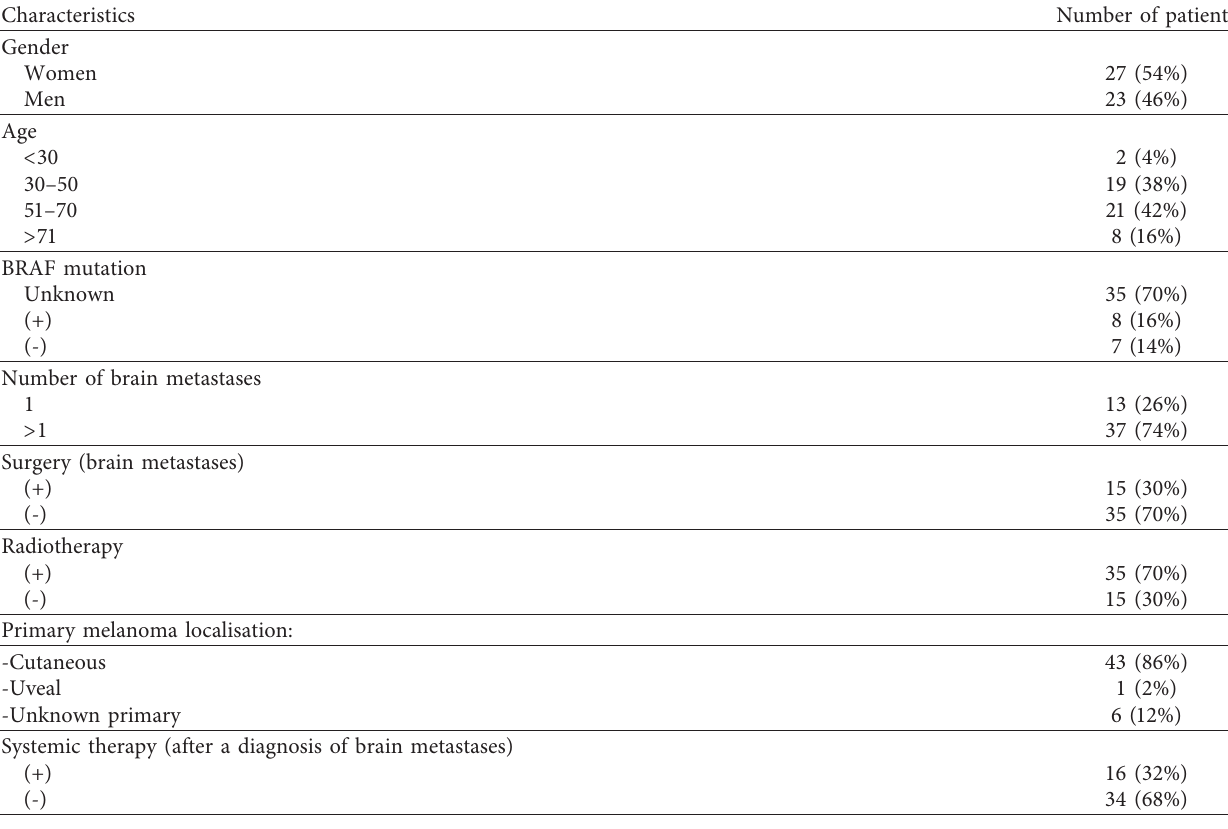
Table 1: Clinicopathological characteristics of the patients.